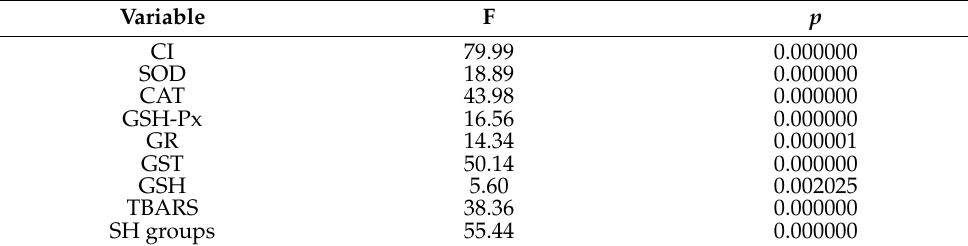
Table 2. Results of one-way ANOVA of the comparison between late larval stage (62 stage), newly metamorphosed, and metamorphosis-arrested (after exposure to low (0.05%) and high (0.1%) thiourea concentrations) crested newts.